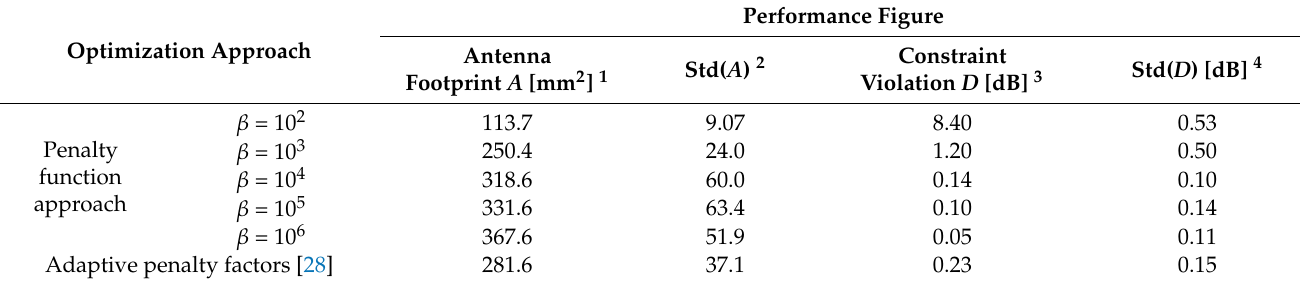
Table 1. Optimization results for antenna of Figure 3.